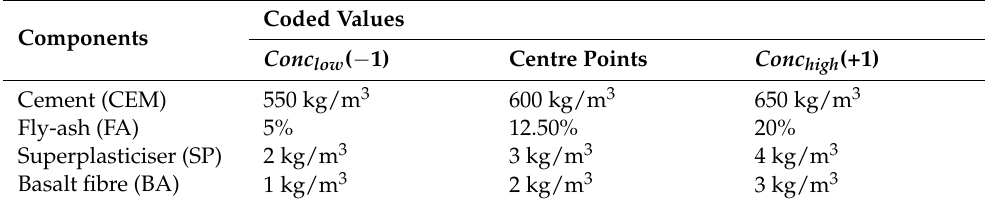
Table 3. Factors and levels